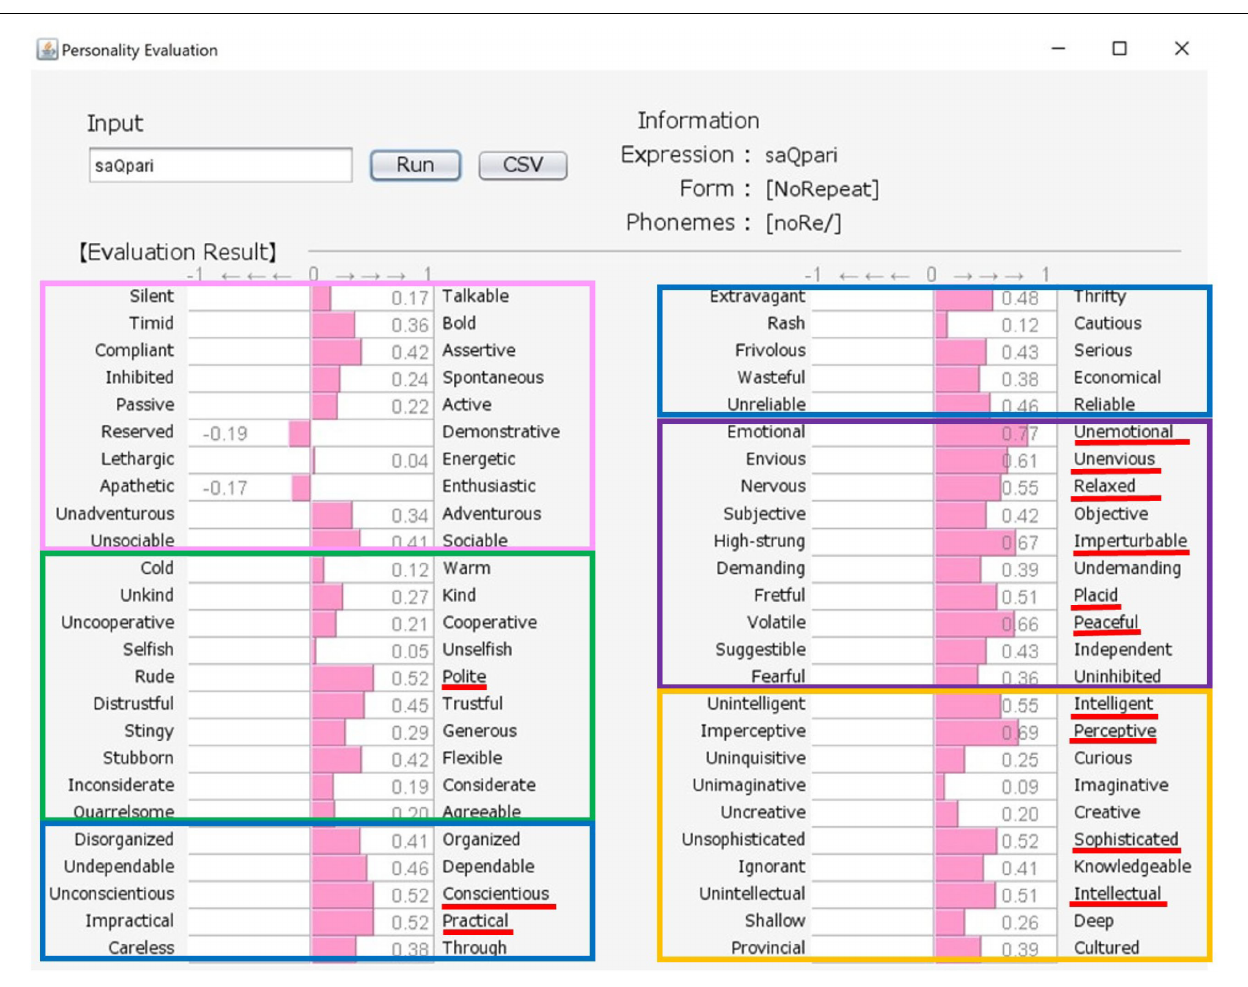
FIGURE 7 | Output for “sappari (nearly equal to frank)” personality. The pink, green, blue, purple, and orange frames indicate Extroversion, Agreeableness, Conscientiousness, Neuroticism, and Openness, respectively.